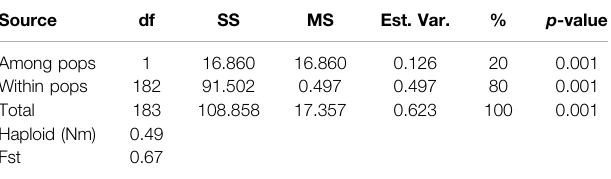
TABLE 2 | Analysis of molecular variance in the panel of 184 genotypes. Source